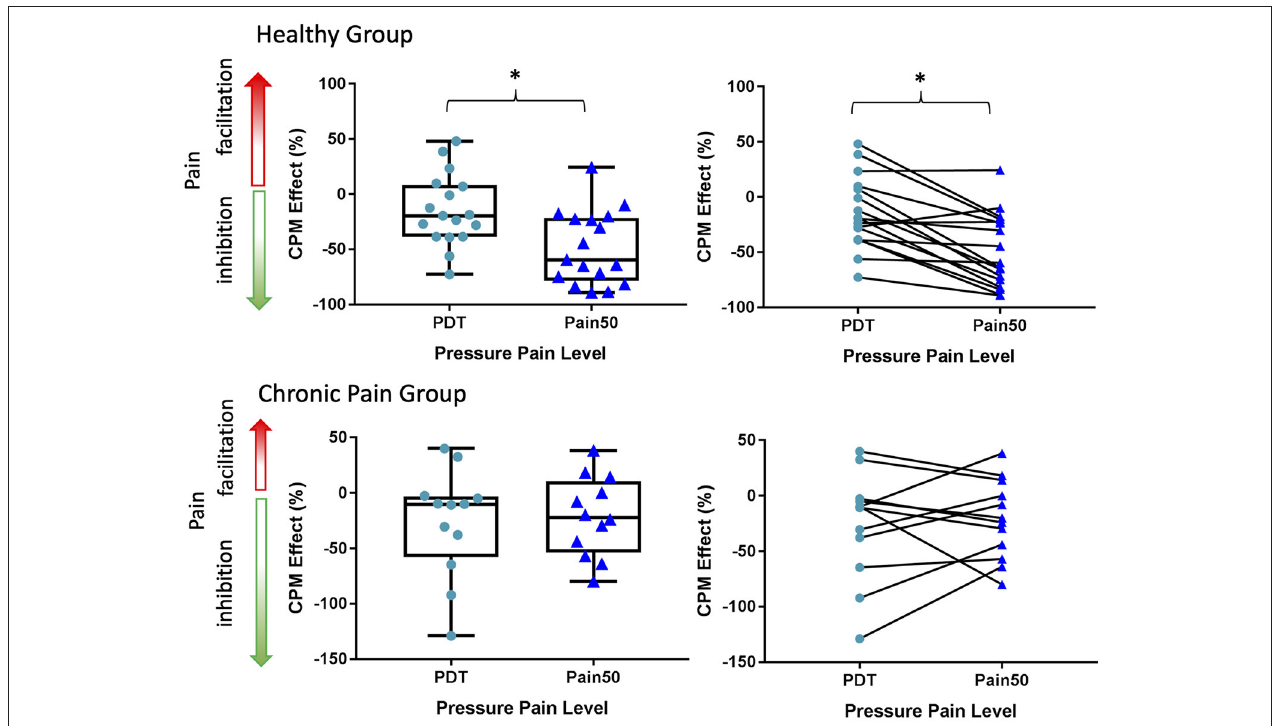
FIGURE 4 | A comparison of CPM effects based on changes in Pain50 vs. the PDT. The CPM effect at PDT and Pain50 only significantly differs in the healthy group. In both the healthy and chronic pain group the inhibitory CPM effect is more pronounced when calculated as a change in pain ratings at Pain50 than a change in the pressure pain detection threshold (PDT). Pain50 is the stimulus intensity that evokes a pain rating of 50/100, where 0 is no pain and 100 is the worst pain imaginable. Line within box is the median, edges of box are 25th to 75th percentiles, and the whiskers denote the maximum and minimum. Asterisks denote significant difference within-subjects ( p <